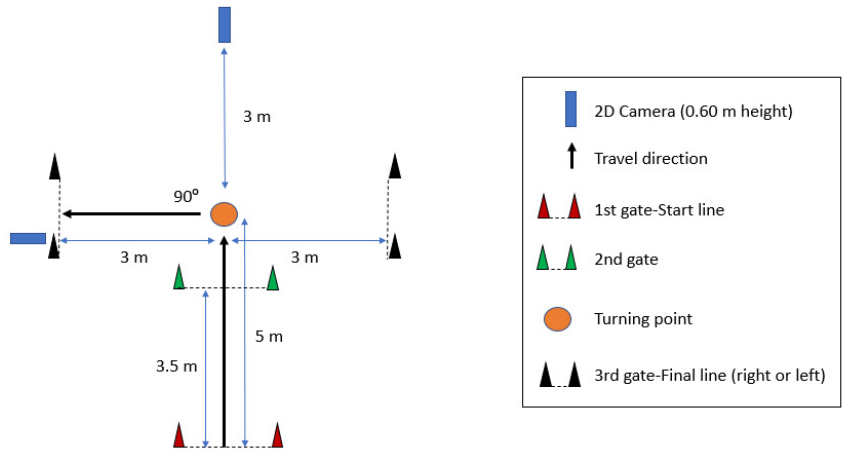
Figure 1. Experimental set-up for the cutting manoeuvre. For cutting to the right, the sagittal camera was positioned on the opposite side, but the procedure was exactly the same.